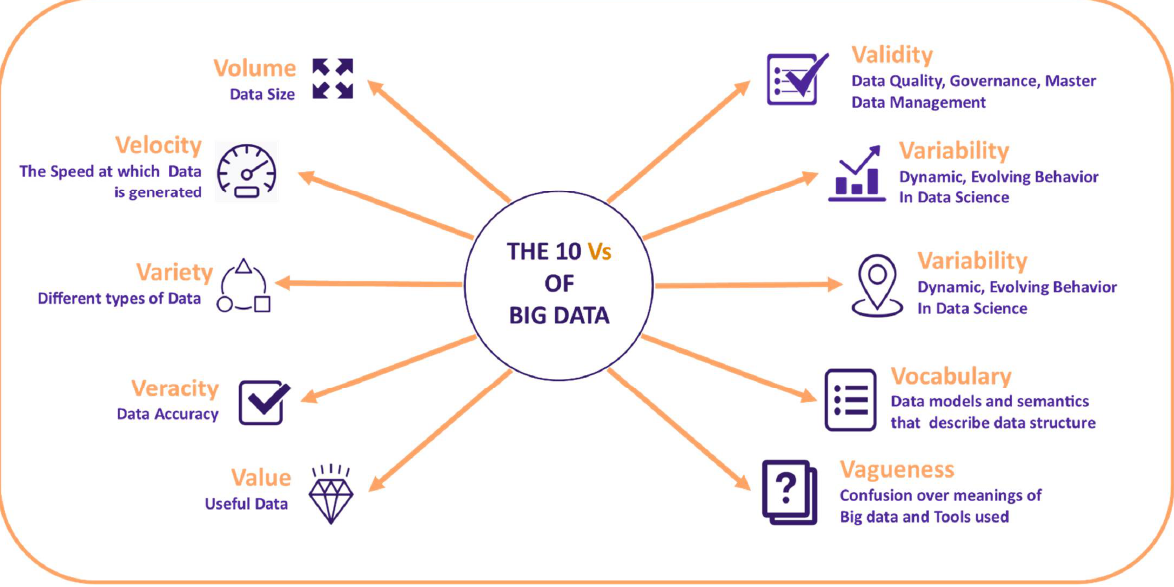
Figure 1. 10’Vs of big data characteristics .